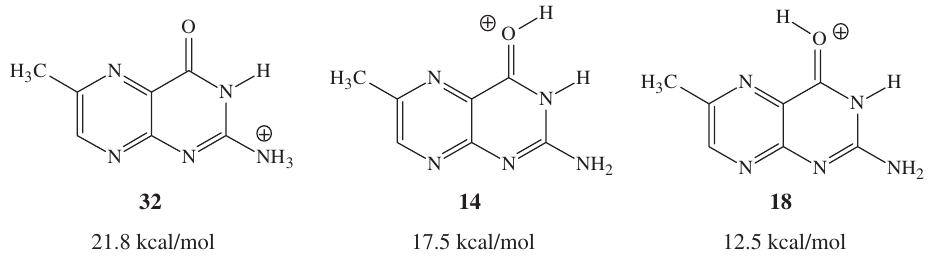
Figure 8 Relative calculated energies of pterins resulting from the non-ring protonation of the lactam structure, 1